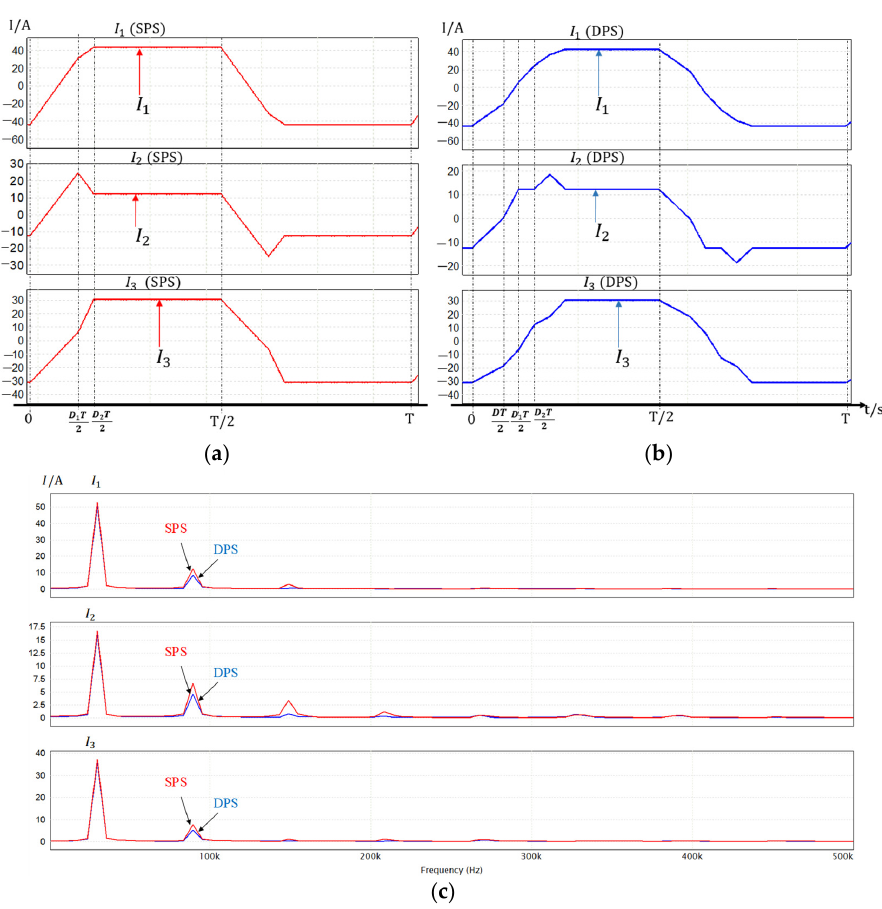
Figure 6. Transformer currents ( a ) SPS control ( b ) DPS control ( c ) frequency response. Table 3. Harmonic distortion for the transformer